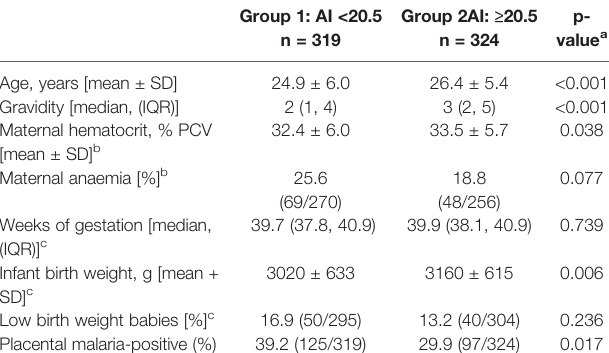
TABLE 2 | Comparison of birth outcomes and AI to